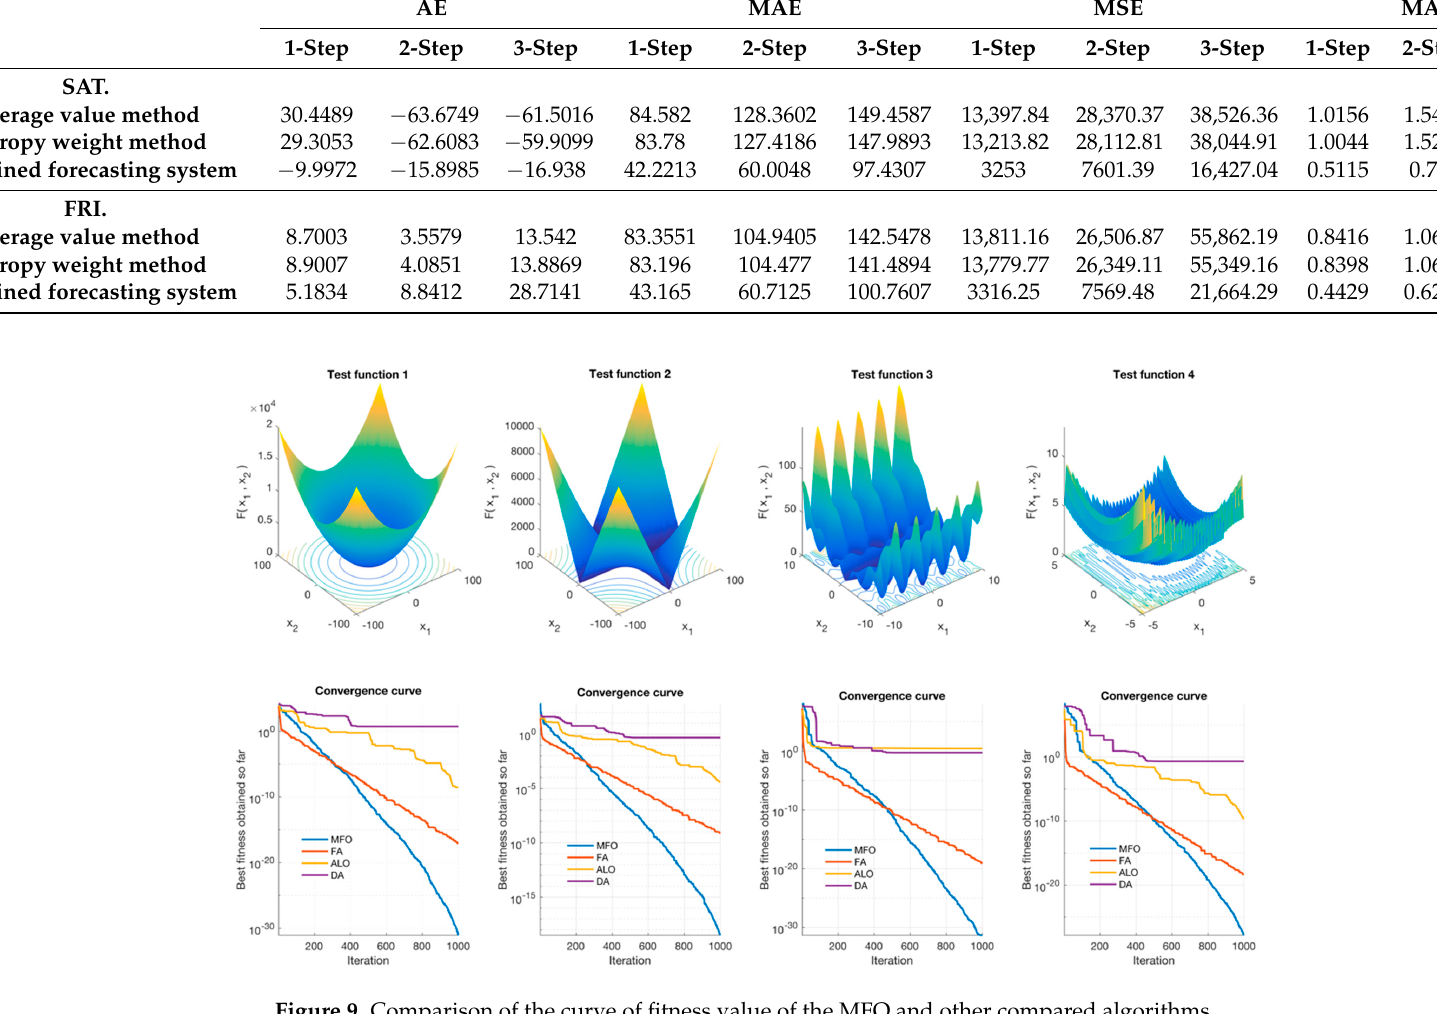
Figure 9. Comparison of the curve of fitness value of the MFO and other compared algorithms.